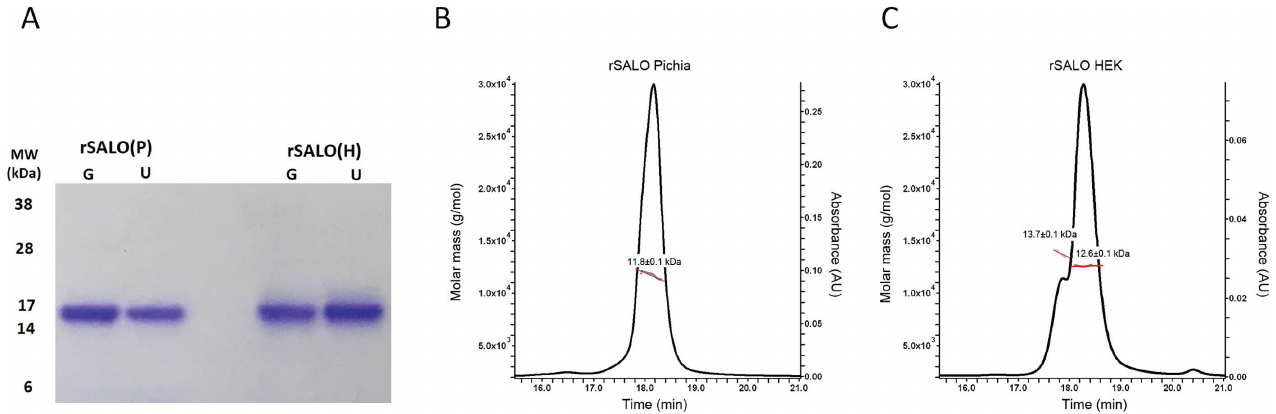
Fig 1. rSALO(P) is pure and monomeric in solution. A) Coomassie G-250 stained NuPAGE Bis-Tris gels under reducing conditionsof 2 μ g purifiedrSALO(P) or rSALO(H). Recombinantproteins were treated with glycosidades (G) or untreated(U) before SDS-PAGE analysis. B) SEC-MALS reveals that rSALO(P) is a monomerin solution with an estimated molecularweight of 11.8 kDa. C) SEC-MALS revealsthat rSALO(H) is made up of different